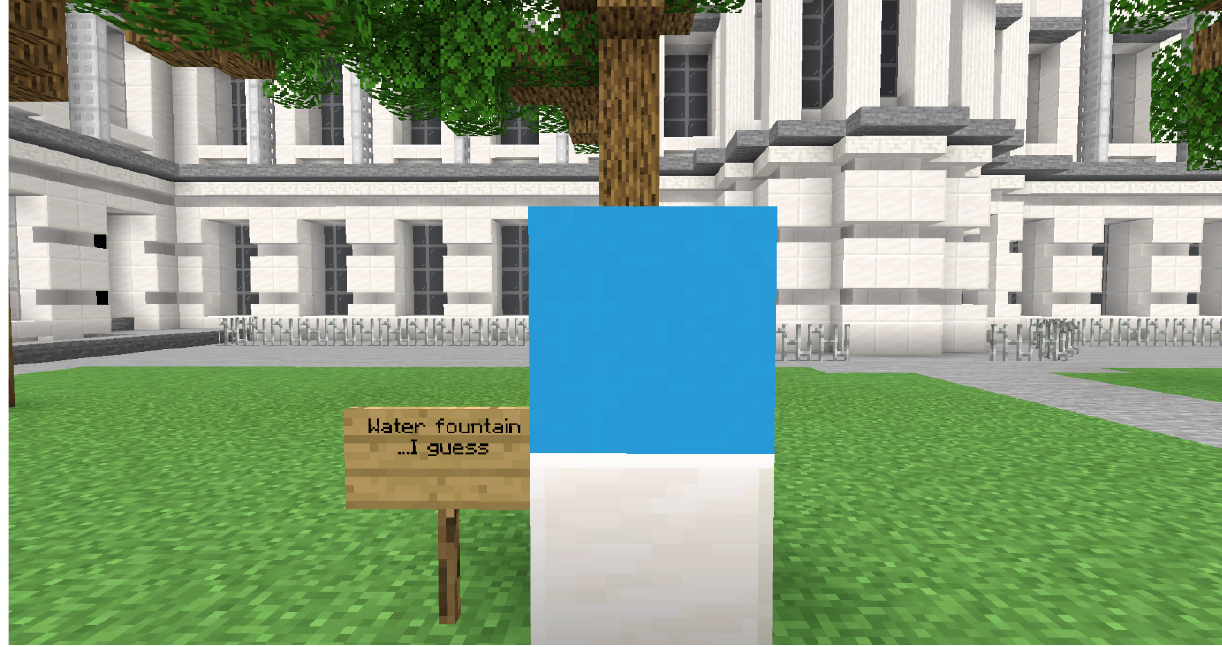
Figure 8. Minecraft plot by BWEvents1: “Water fountain… I